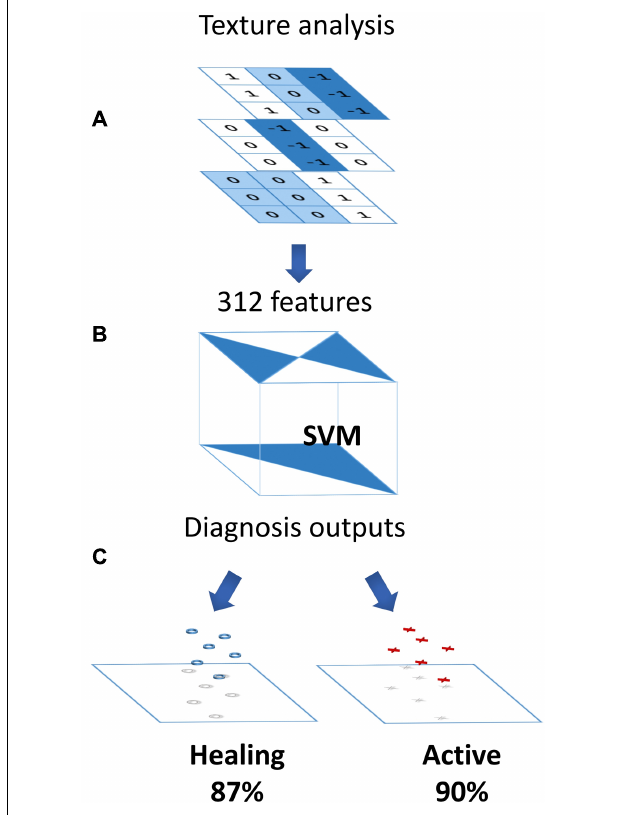
FIGURE 3 | Computer-aided diagnosis for endocytoscopy to identify histological inflammation. (A) Three-hundred and twelve features collected by endocytoscopic and texture analysis. (B) SVM based on the 312 features classifying 2-class diagnoses (“active” or “healing”). (C) The status and diagnostic probability were published. Adapted with permission from Maeda et al. (2019),